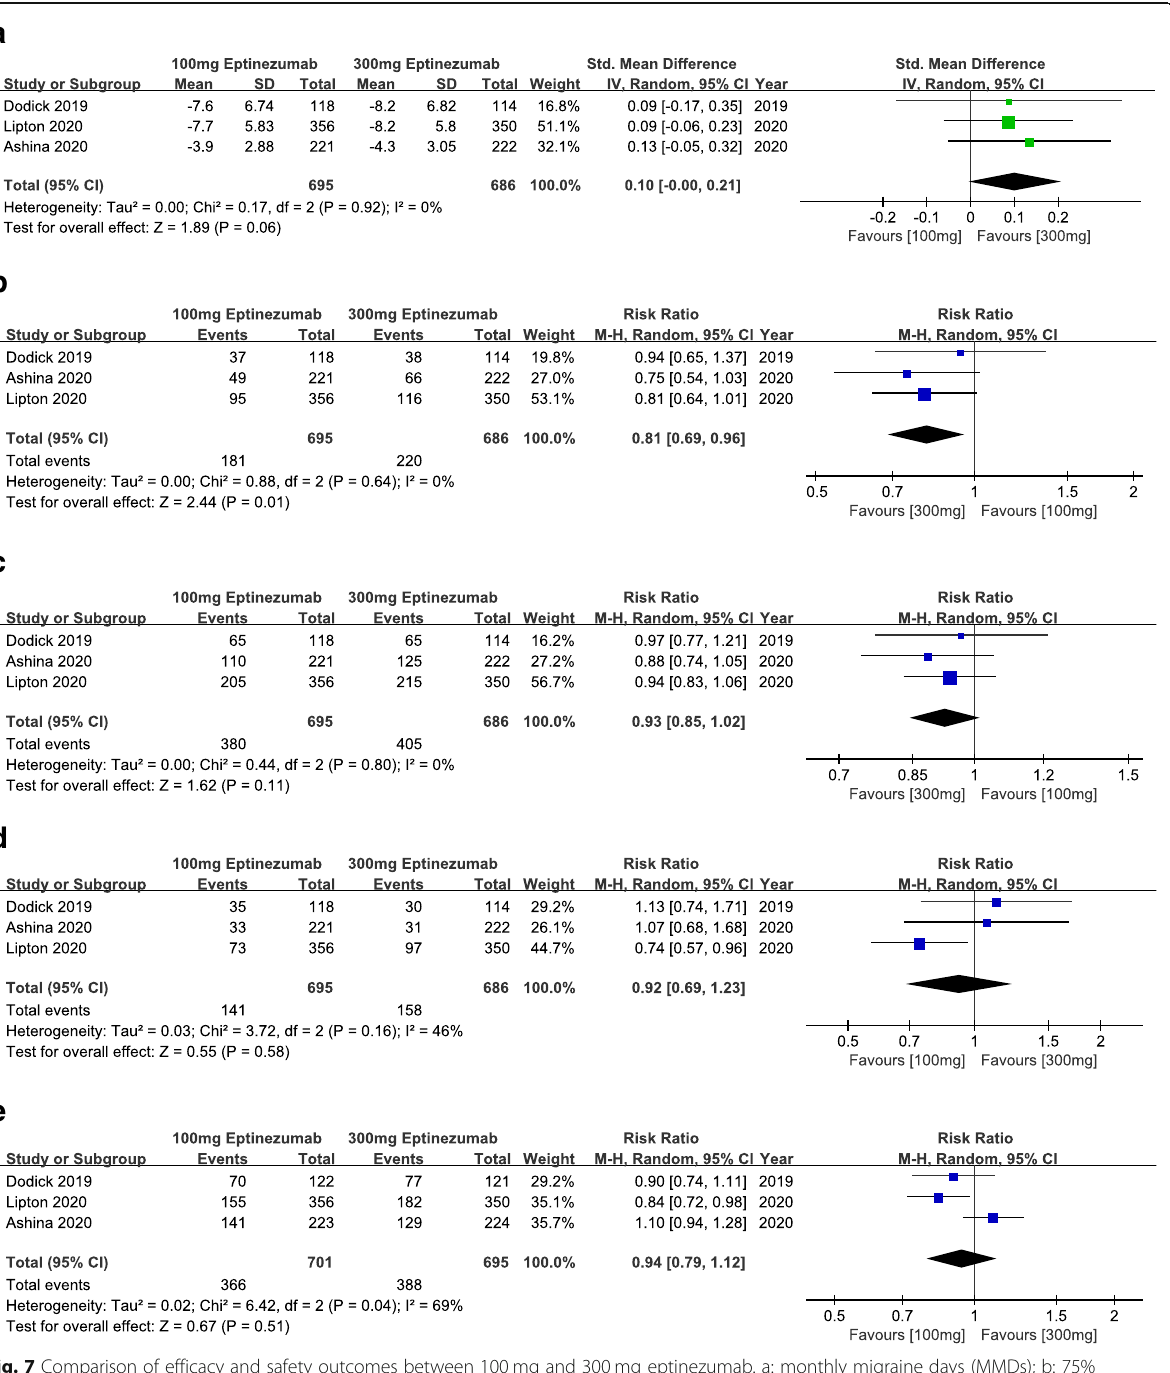
Fig. 7 Comparison of efficacy and safety outcomes between 100 mg and 300 mg eptinezumab. a: monthly migraine days (MMDs); b: 75% responder rate; c: 50% responder rate; d: patients with migraine 1 day after dosing; e: treatment emergent adverse events